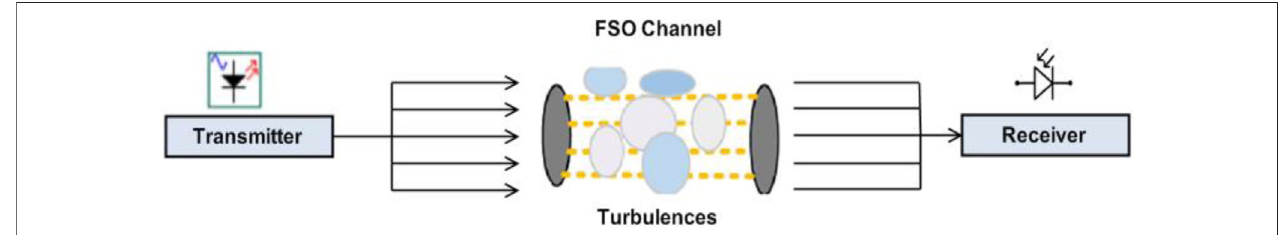
FIGURE 2 | Illustration for cooperative diversity using the MIMO technique.